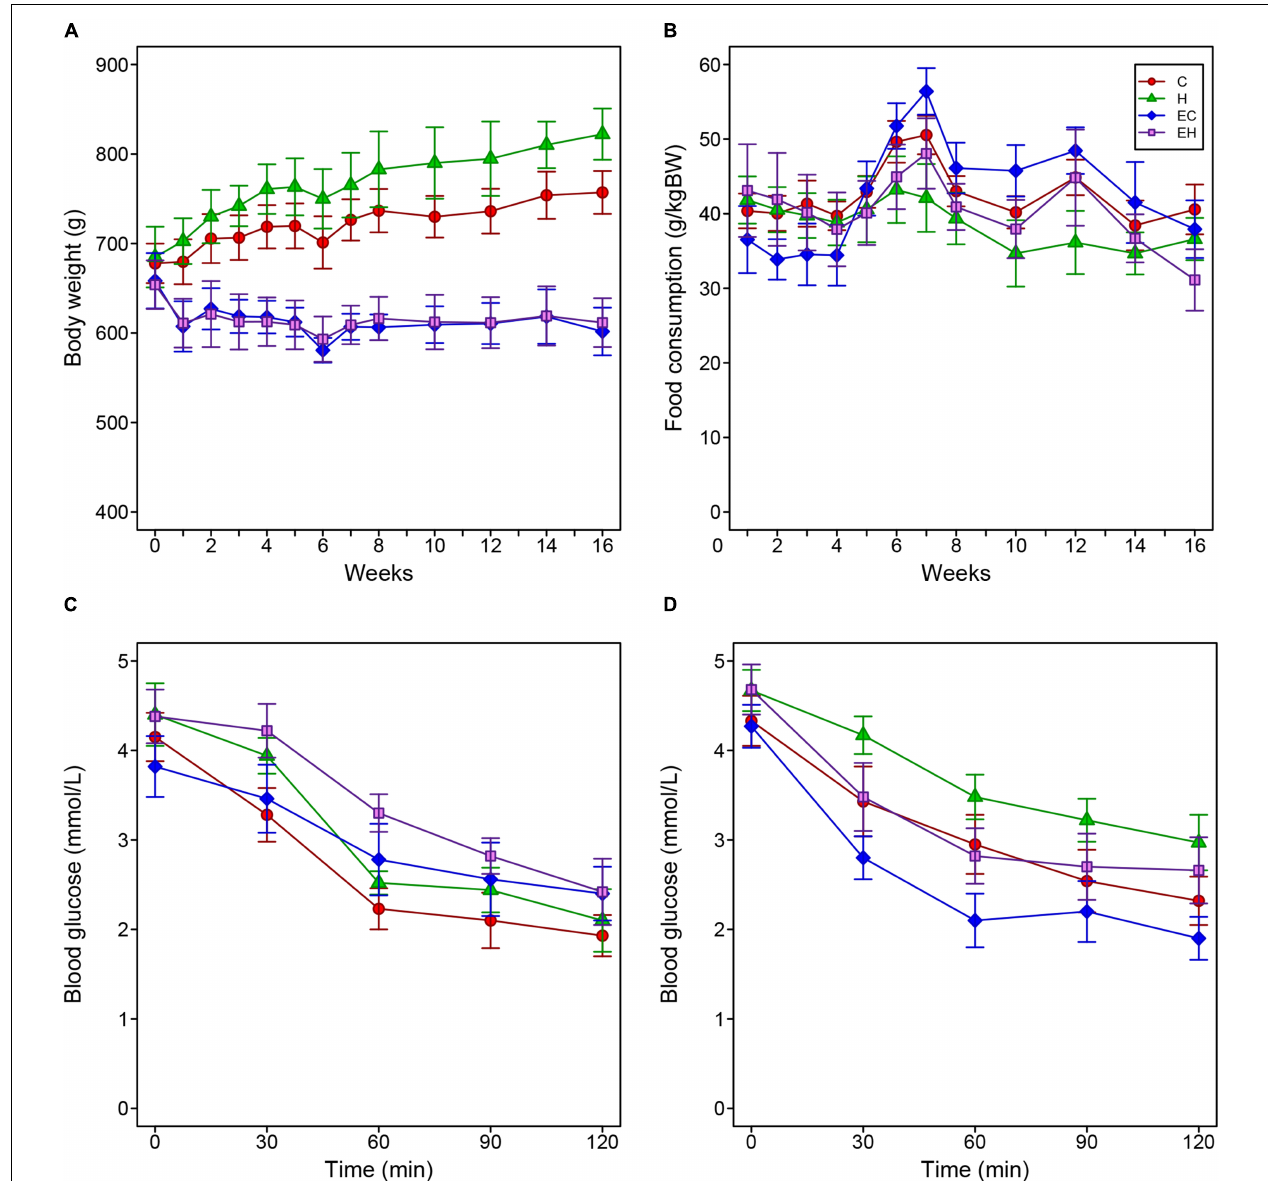
FIGURE 1 | Changes of body weight (A) and food consumption (B) of the rats during the whole period of the experiment, and the results of injected insulin tolerance tests pre- (C) and post-intervention (D)